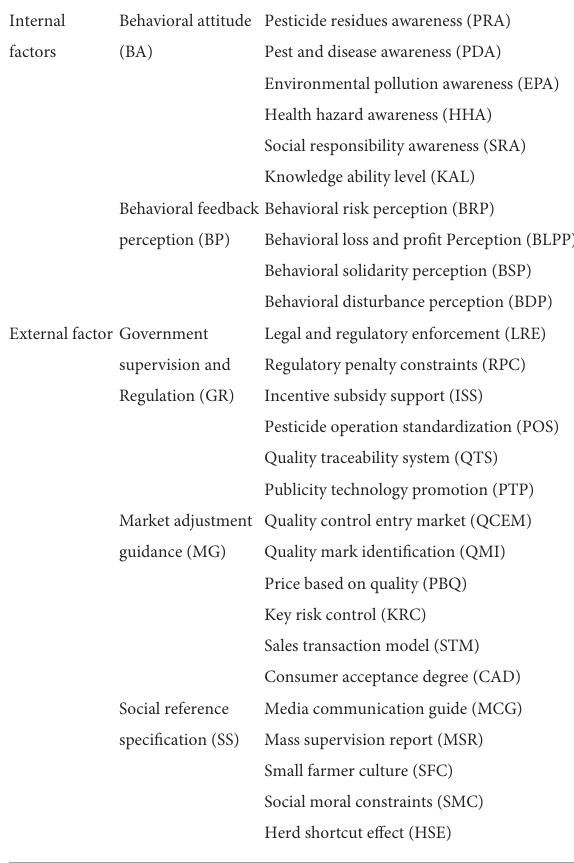
TABLE 3 Main categories formed through spindle